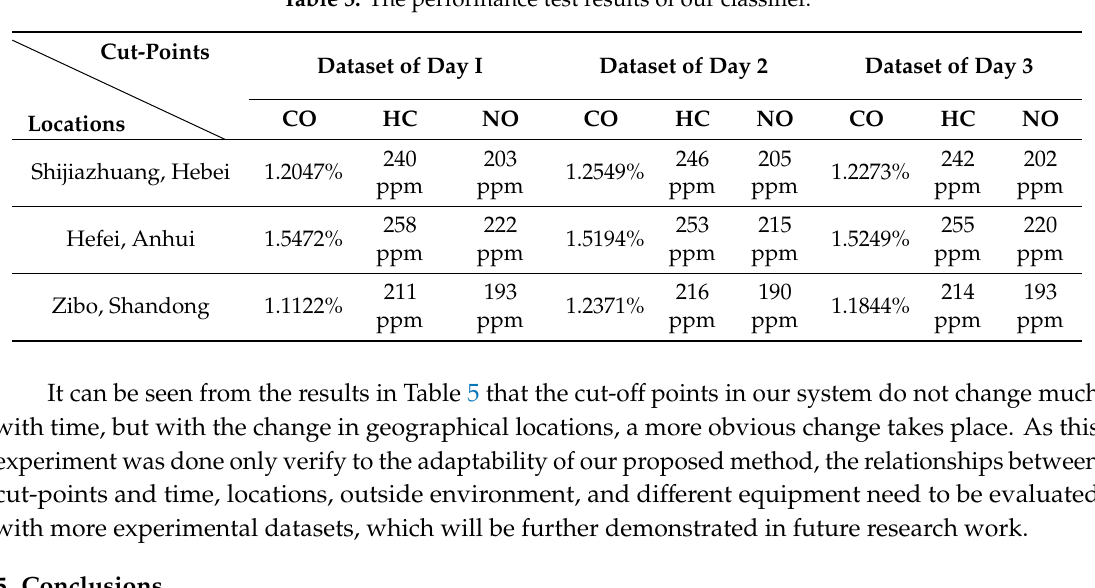
Table 5. The performance test results of our